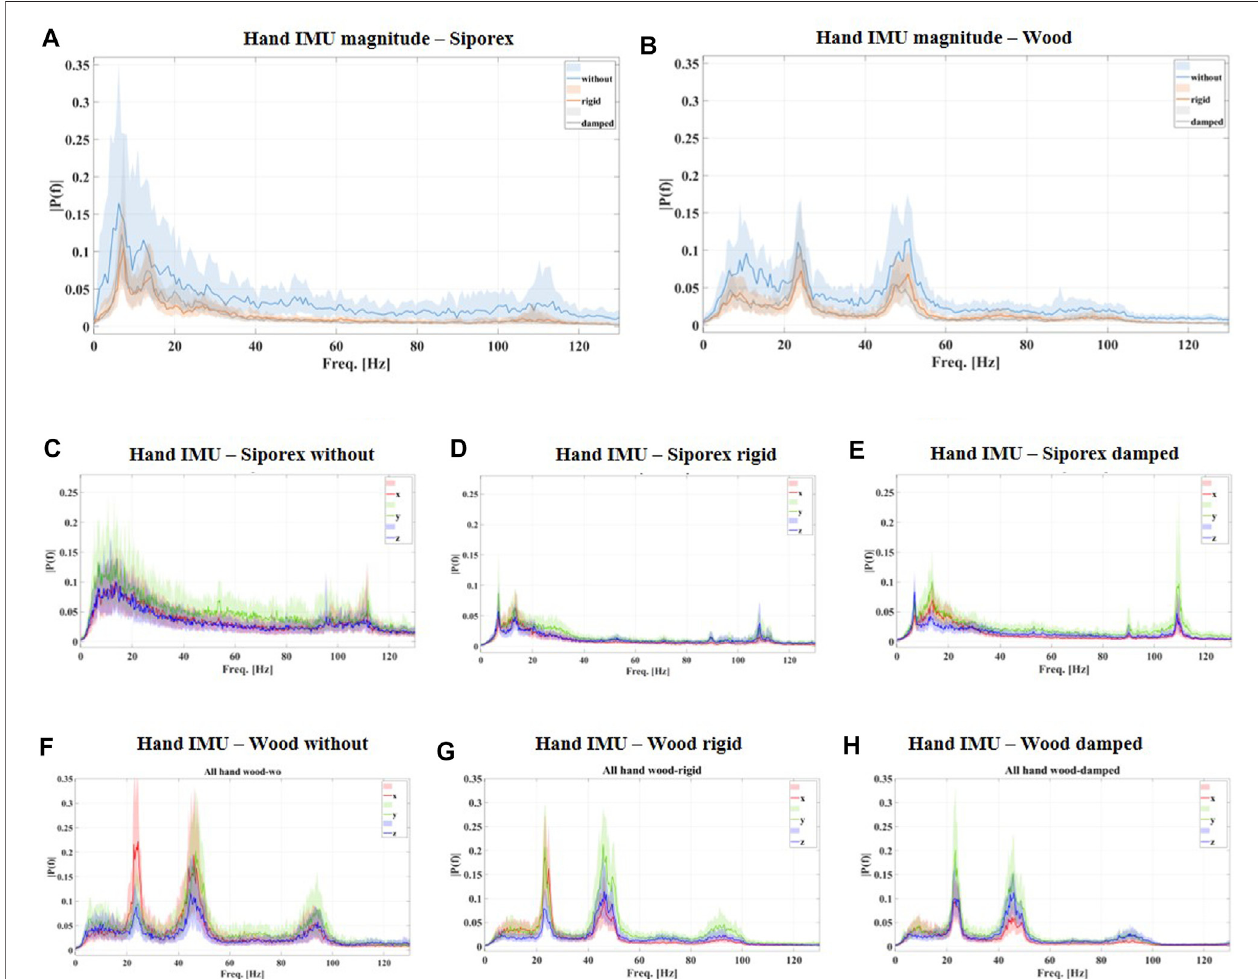
FIGURE 7 | frequency spectra of the hand vibration during the drilling in phase for all the subjects are shown. In particular, (A,B) the spectrum of the magnitude acceleration for thethree different con fi gurations ( without in light-blue, rigid in orange, and damped in gray) drilling in SIPOREX (A) and wood (B) . (C,D,E) The frequency spectrum of the acceleration along the three axes (x in red, y in green, and z in blue) for the three different con fi gurations in drilling SIPOREX; (F,G,H) the frequency spectrum of the acceleration along the three axes (x in red, y in green, z in blue) for the three different con fi gurations in drilling wood. All the curves represent the median Discrete Fourier Transform among all the holes of all the subjects. Color bands represent the interquartile